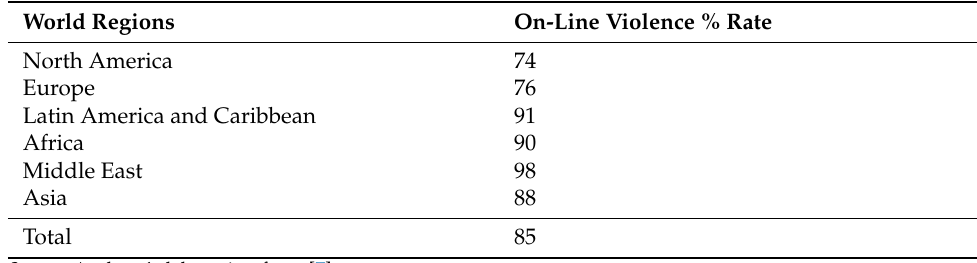
Table 1. Online prevalence rate by regions (2020). World